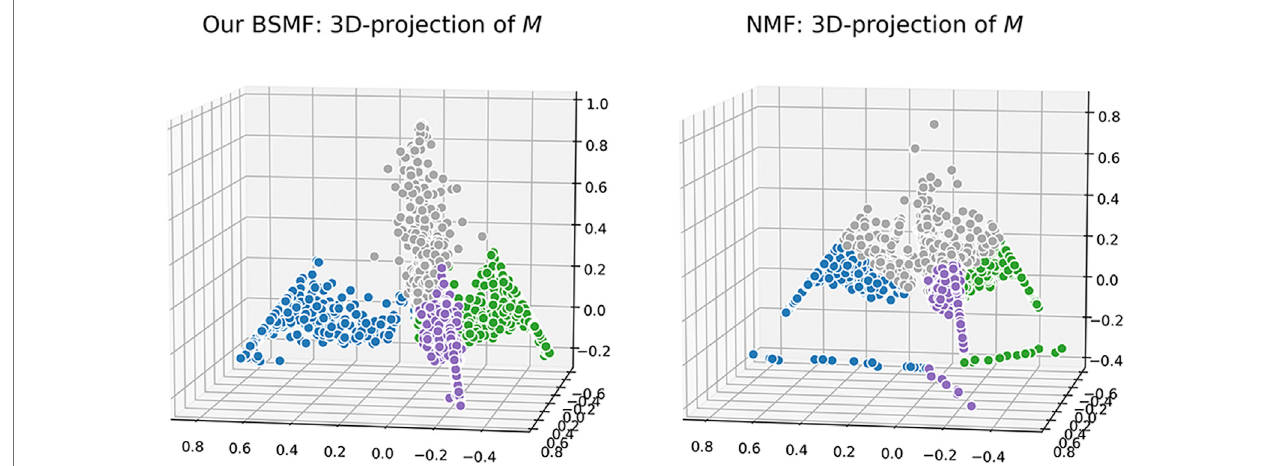
FIGURE 4 | Visualization of M for our BSMF (left) and NMF (right) .